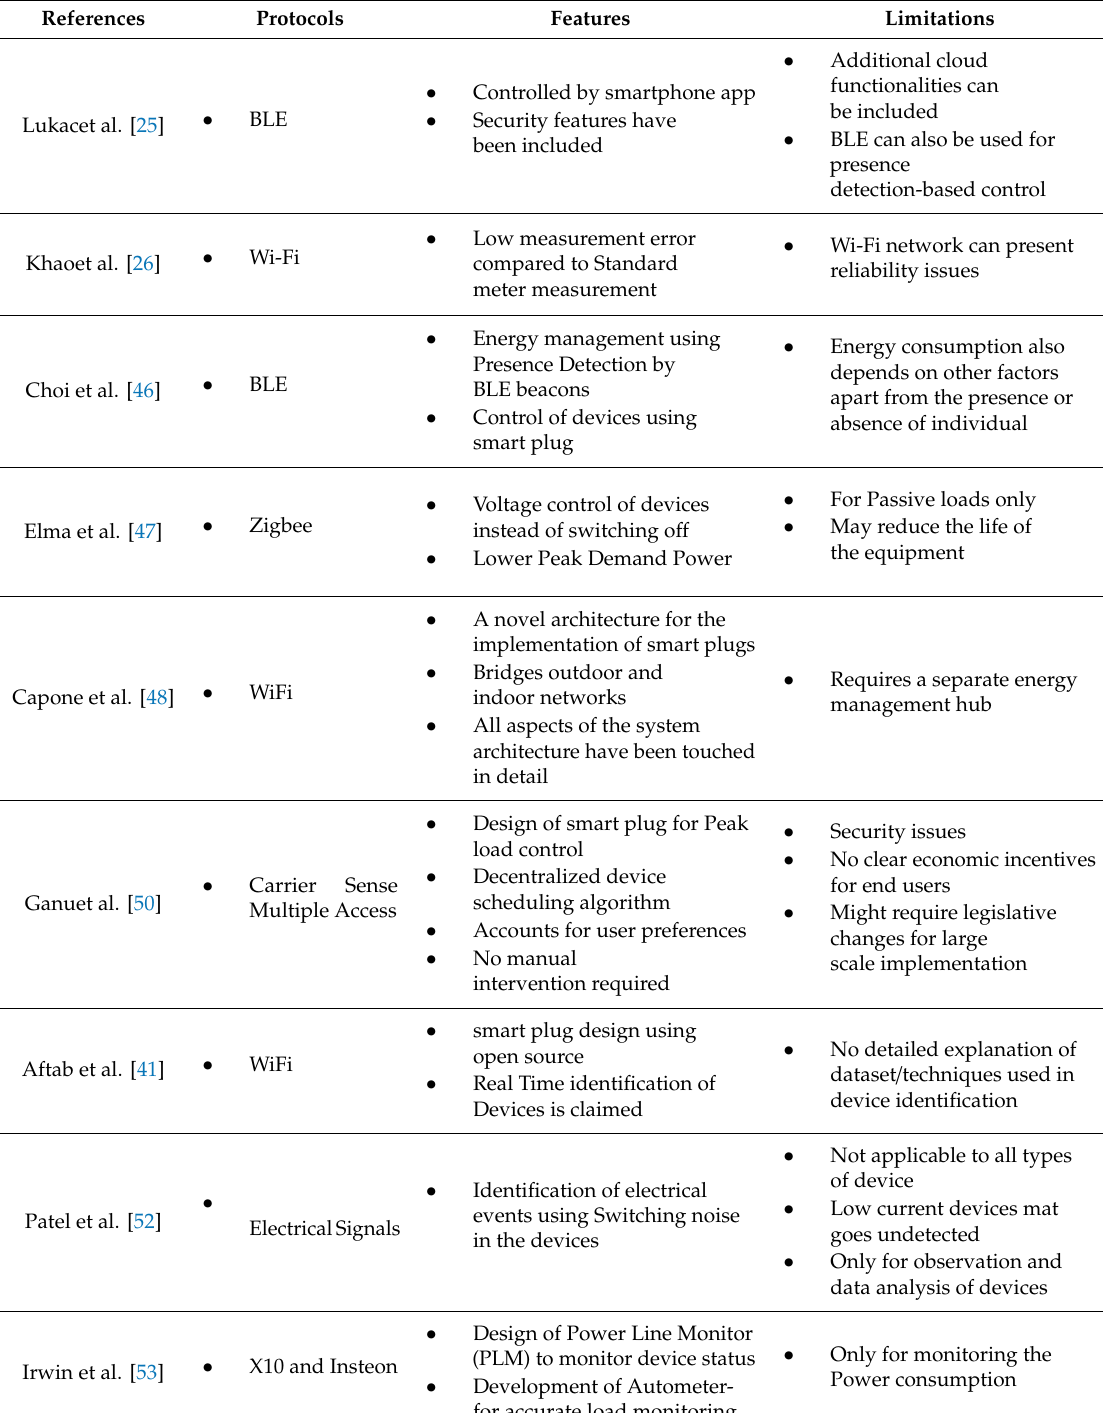
Table 1. Summary of Design and